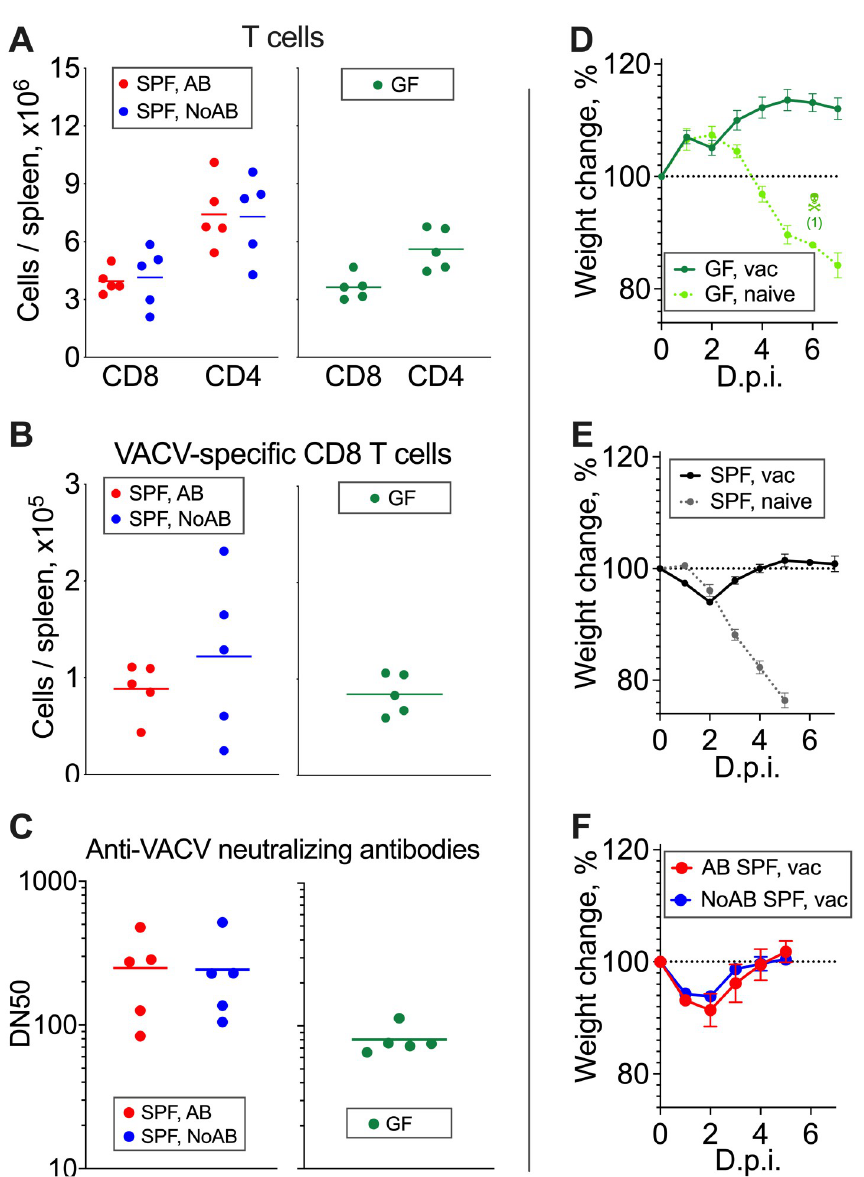
Fig 7. VACV-specific antibody and CD8+ T cell memory response and virus challenge of vaccinated mice. (A-C): SPF or GF mice ( n = 5) were injected i.d. with 10 4 PFU of VACV. SPF, AB-group received i.p. antibiotic treatment for 10 d from 1 d p.i. SPF, NoAB group received i.p. injections with PBS. Spleens and serum samples were obtained at 34 d p.i. (A) Absolute number of splenic CD8 + and CD4 + T cells. Bars represent means. (B) Absolute number of VACV- specific splenic CD8 + T cells. Bars represent means. (C) VACV-neutralising antibody responses determined by plaque- reduction neutralisation test. IC50, half maximal inhibitory concentration. Bars represent means. All experiments (except with GF mice) were performed twice and representative data from one experiment are shown. The experiments with GF mice were performed once and in a facility separate from SPF experiments. (D-F): GF and SPF groups of mice ( n = 5 per group) were vaccinated (“vac”) i.d. in both ears with 10 4 PFU of VACV WR per ear. “Naive” groups ( n = 3–5) were not vaccinated. AB and NoAB groups were treated as in (A-C). One month p.i. groups were challenged i.n. with (D, E) 3 × 10 6 PFU or (F) 6 × 10 6 PFU of VACV WR. Data represent the weight of each mouse compared to the weight of the same animal before challenge (d 0). The percentages for each group are means with